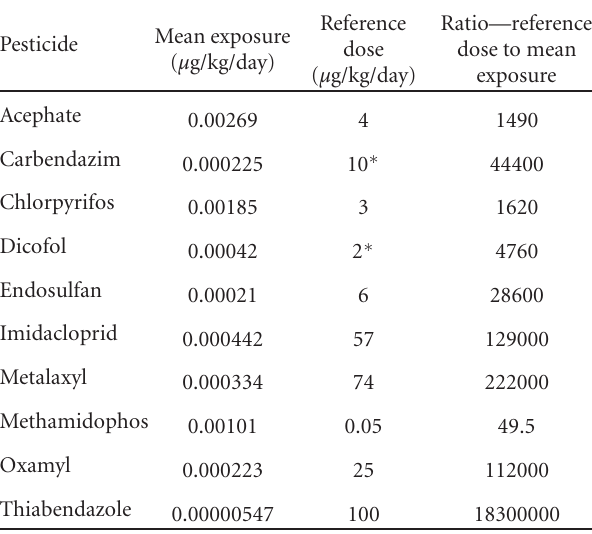
Table 1: Number of samples analyzed by PDP for pesticide residues for each of the twelve commodities studied and the most recent year of sample collection.